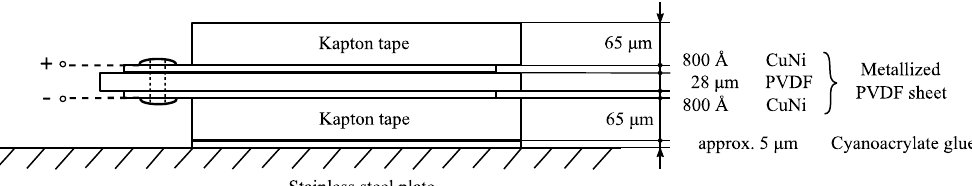
Figure 1. The home-made sensor composition .